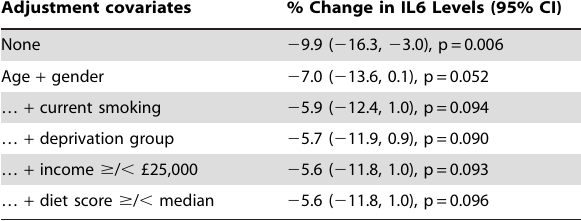
Table 3. Highlights the percentage change in IL6 levels that is associated with an increase in telomere